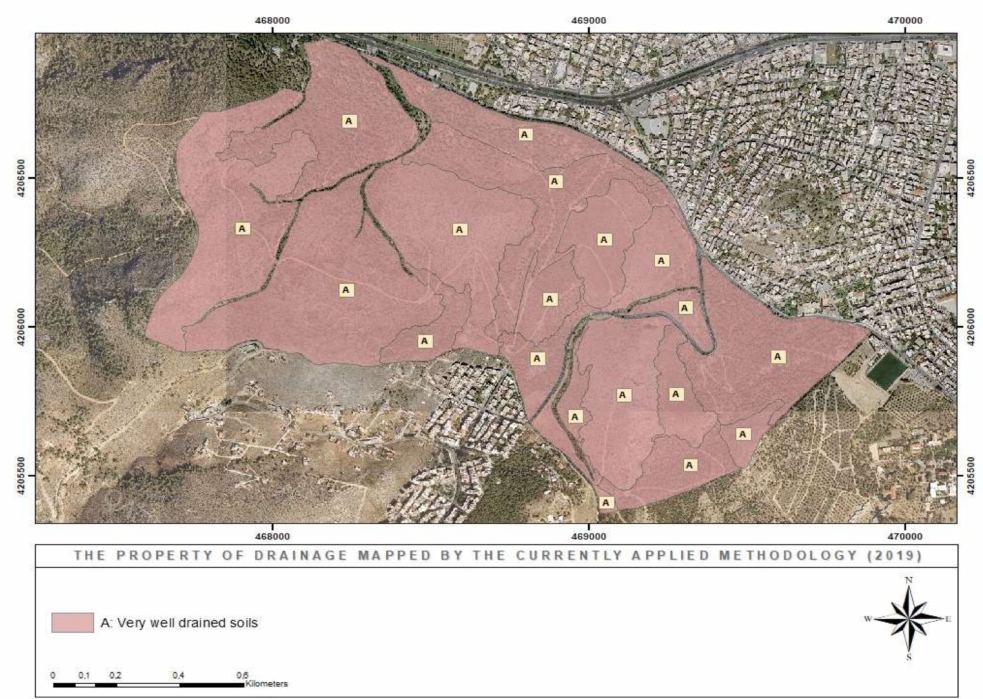
Figure 12. Drainage map of the currently applied mapping